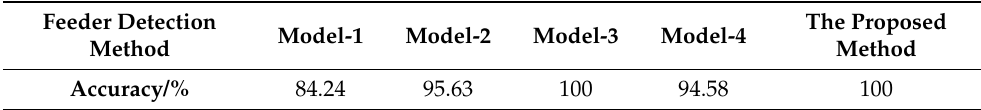
Table 4. Feeder detection results of different